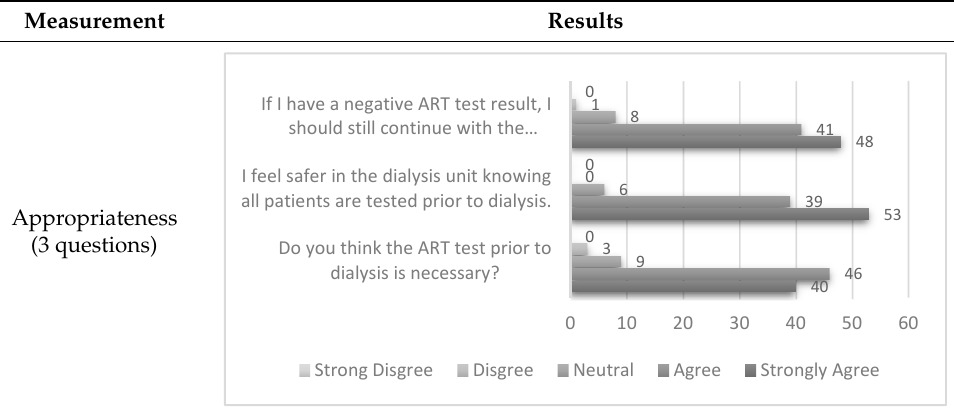
Table 2. Appropriateness of ARTs.